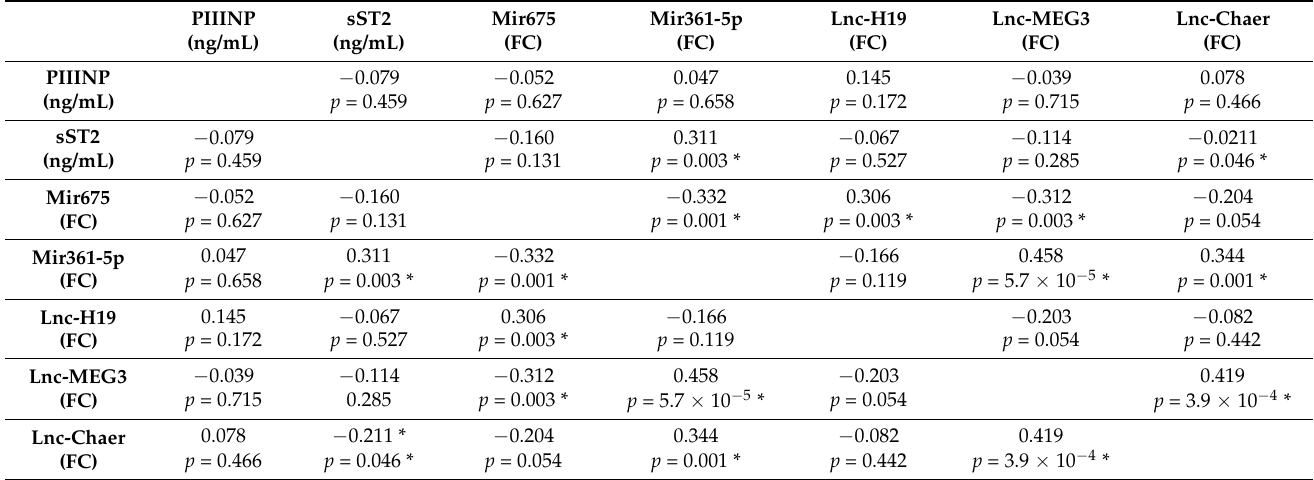
Table 10. Correlation between cardiac biomarkers and non-coding RNA among MACE patients.